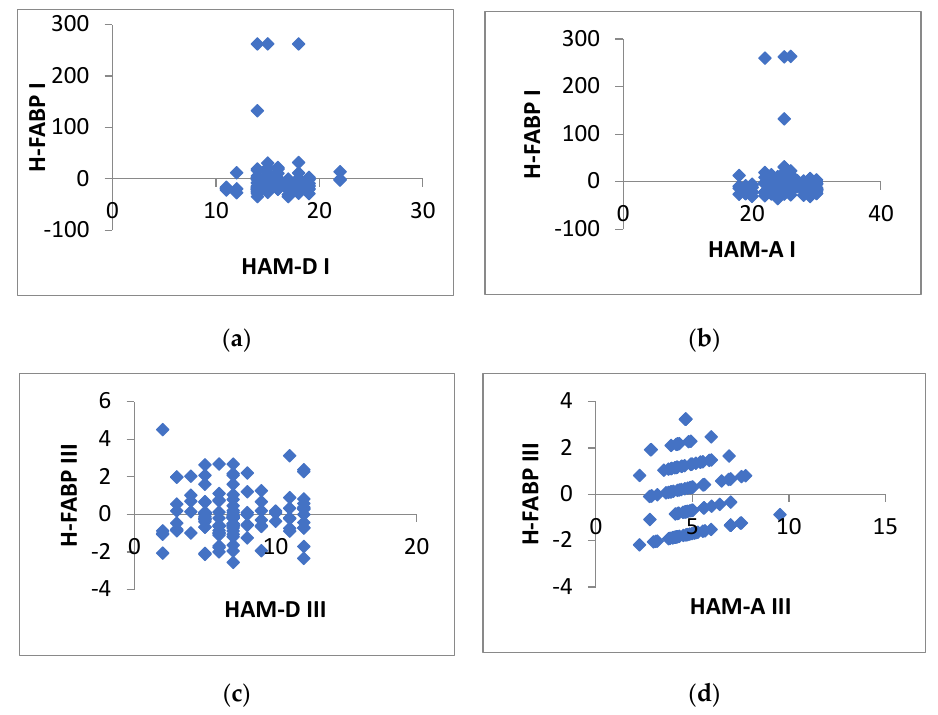
Figure 3. Insignificant negative associations between H-FABP levels and psycho-emotional scores: ( a ) H-FABP and HAM-D in phase I; ( b ) H-FABP and HAM-A in phase I; ( c ) H-FABP and HAM-D in phase III; ( d ) H-FABP and HAM-A in phase III ( N = 120).